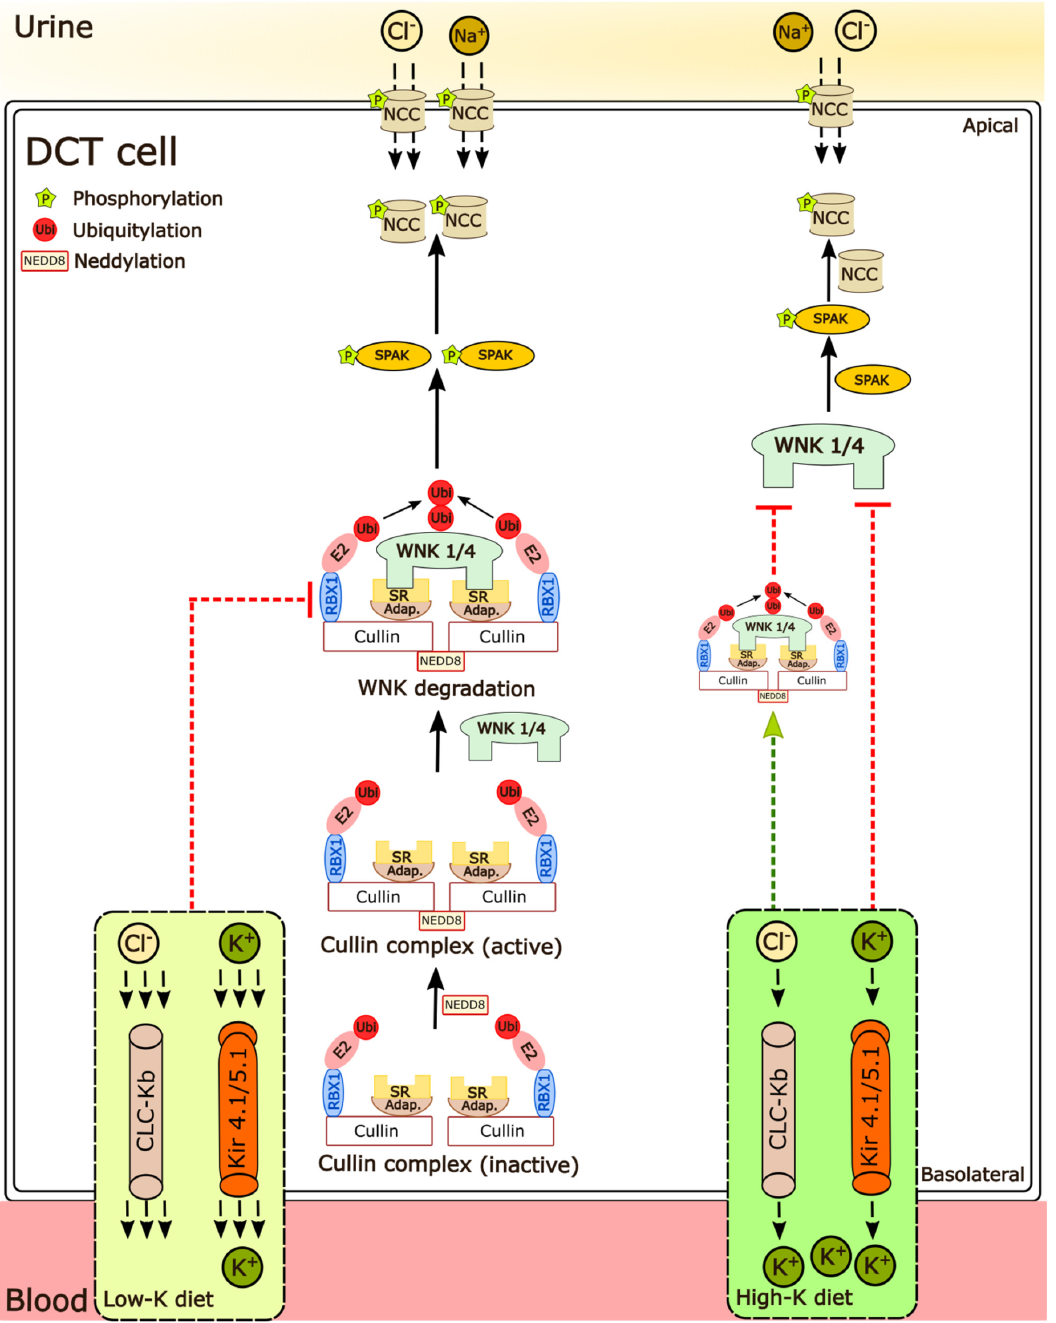
Figure 9. Regulation of NCC phosphorylation under different K + conditions. Cullins are a family of E3 ligases that are activated through neddylation, a post-translational modification in which the ubiquitin-like modifier NEDD8 is covalently attached to the target protein. Active cullin complexes can bind to their substrate, resulting in target ubiquitylation and subsequent degradation. Higher extracellular K + concentrations limit NCC phosphorylation, but this effect is attenuated in the absence of active cullins, suggesting that the responses on NCC are partly dependent on cullin activity. A lower extracellular K + concentration increases SPAK and NCC phosphorylation, but not as much in the absence of active cullins. Although this suggests that the effects of low extracellular K + on NCC phosphorylation are fully dependent of cullin activity, more likely is that in the absence of cullin activity WNK, SPAK, and NCC phosphorylation are already maximized and no further increases are possible. SR-substrate receptor; Adap.-adaptor